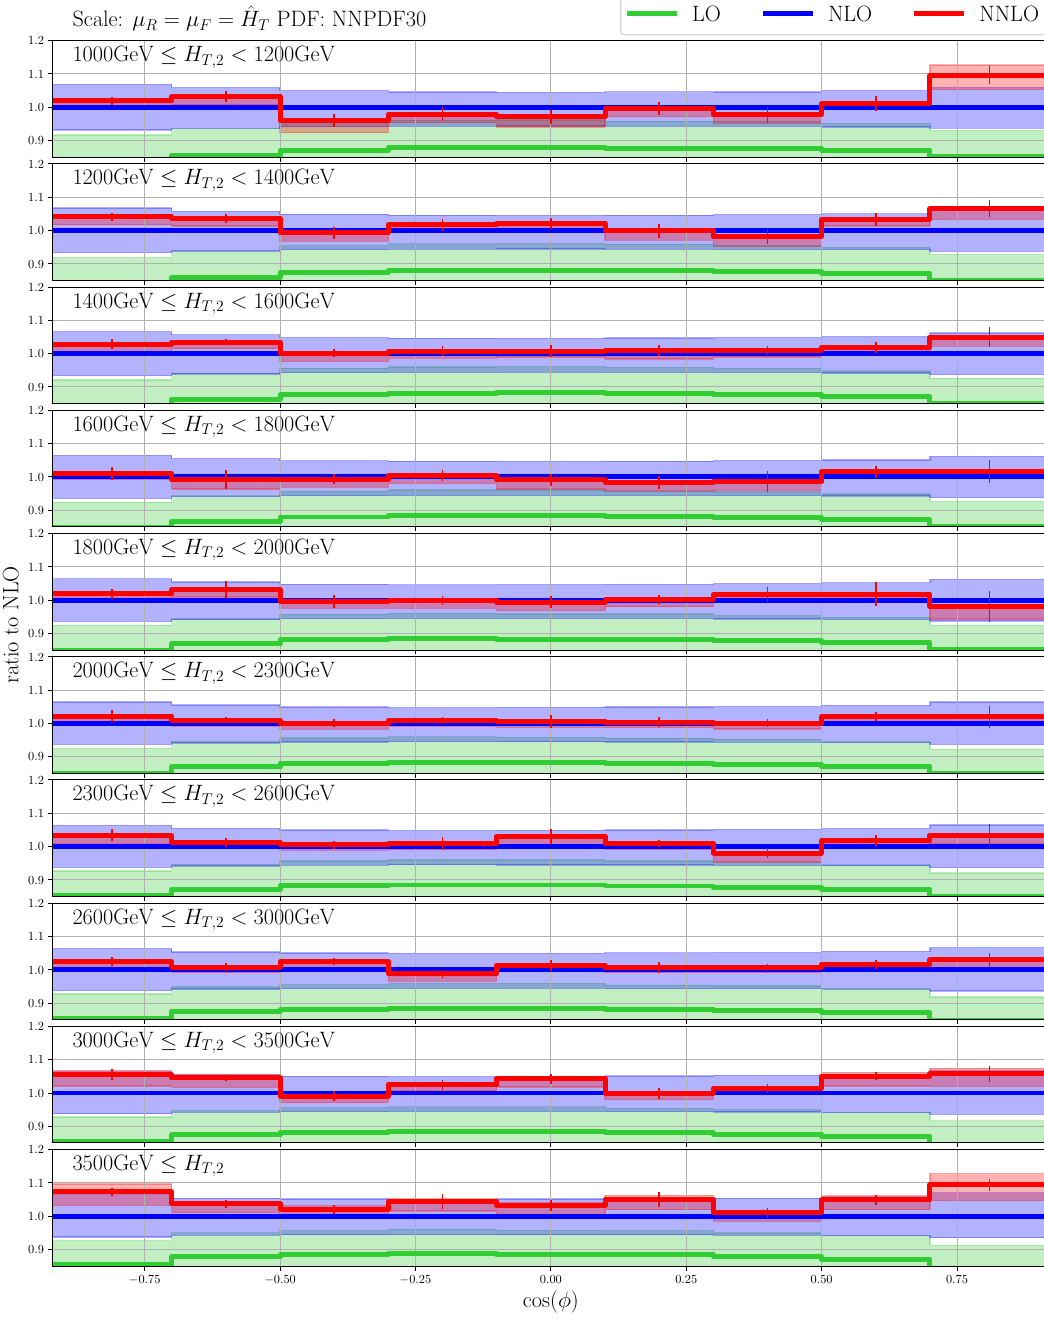
Figure 5 . The TEEC variable double differentially in H T, 2 bins. The panels show LO (light green), NLO (blue) and NNLO (red) QCD prediction as a ratio to the central NLO QCD prediction. The coloured bands show the scale uncertainty estimates and vertical bars indicate statistical